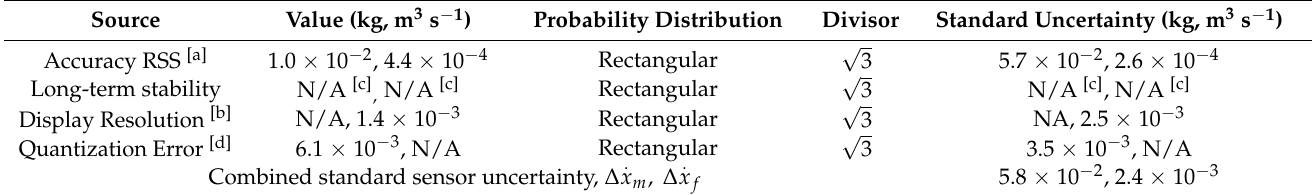
Table 8. Uncertainty budget for propane for both mass and flow basis.